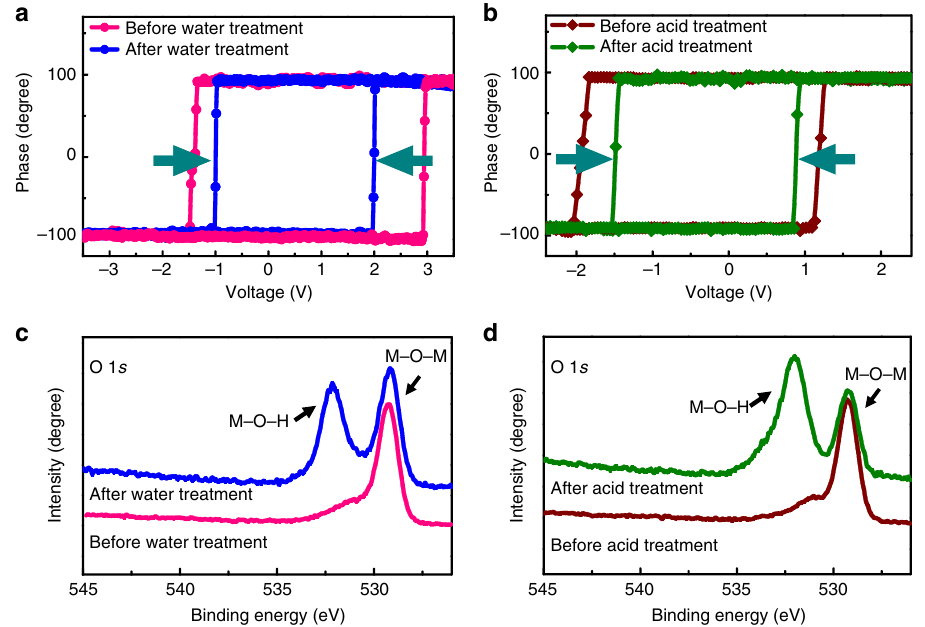
Fig. 3 New chemical bond formation after aqueous-solution treatments. Corresponding typical quasi-static piezoresponse hysteresis loops show that coercive fi elds decreased after Milli-Q-water-induced polarization switching ( a ) and acidic-solution-induced polarization switching ( b ). X-ray photoelectron spectroscopy spectrums showing an appearance of peak belongs to M – O – H bond after the polarization reversed in Milli-Q water ( c ) and acidic solution ( d ), indicating a signi fi cant formation of new surface chemical structure on